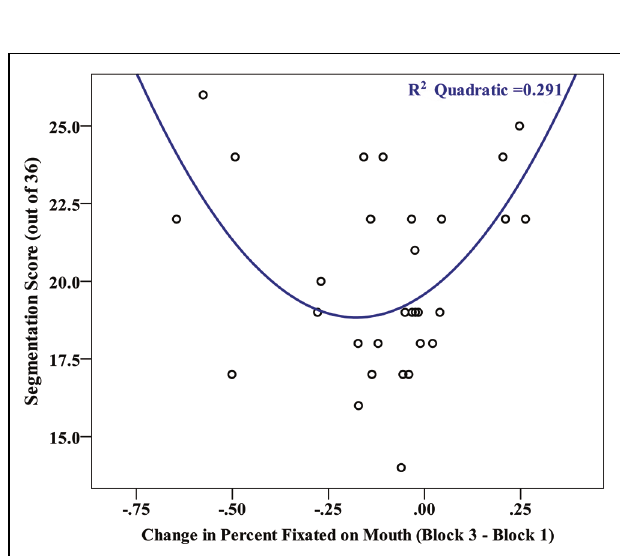
FIGURE 6 | Scatterplot depicting the relationship between the magnitude of a participants’ gaze shift (Block 3–Block 1 in percent viewing time on the mouth) and their segmentation score (# correct out of